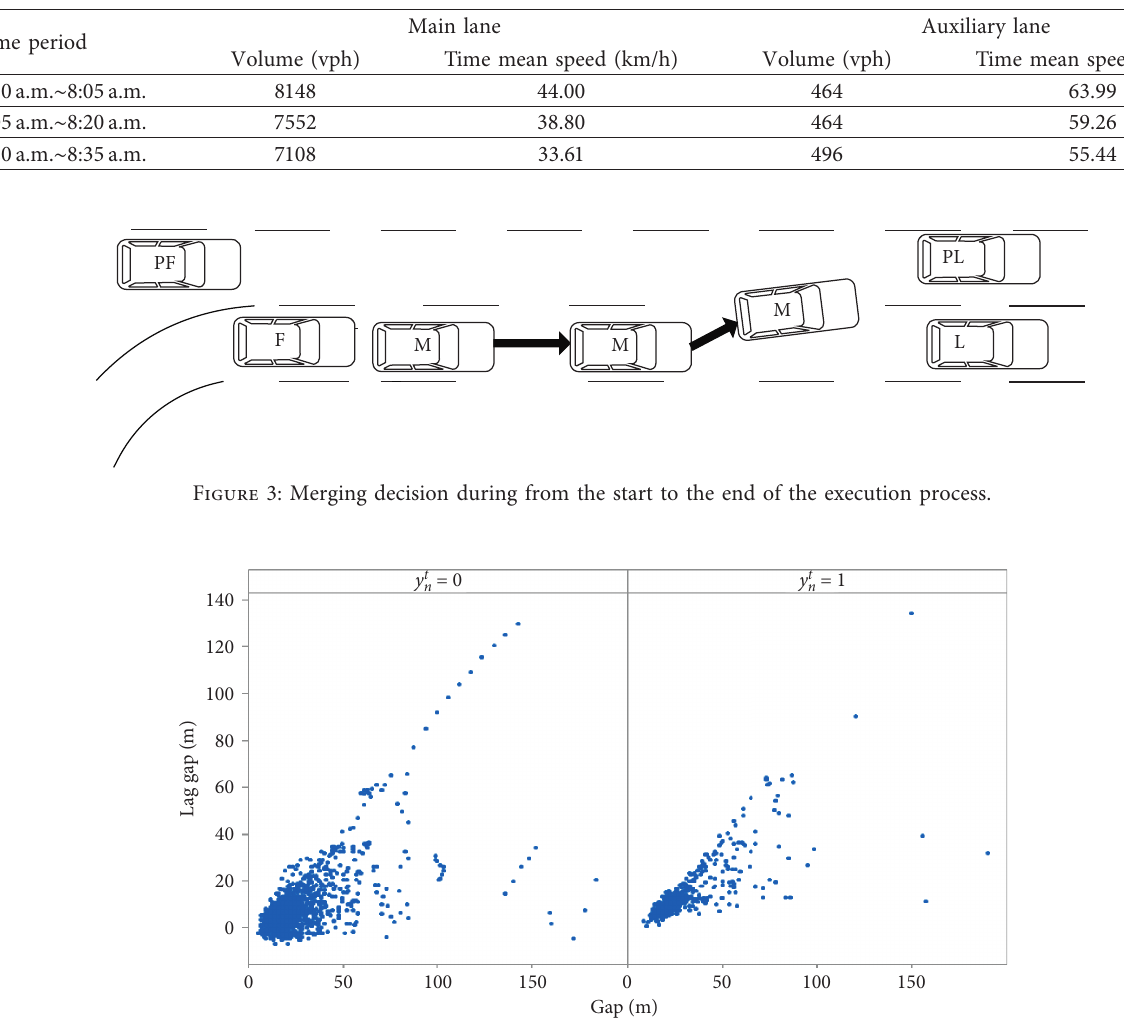
Figure 4: Relationship between the lag gap and the accepted gap in the main